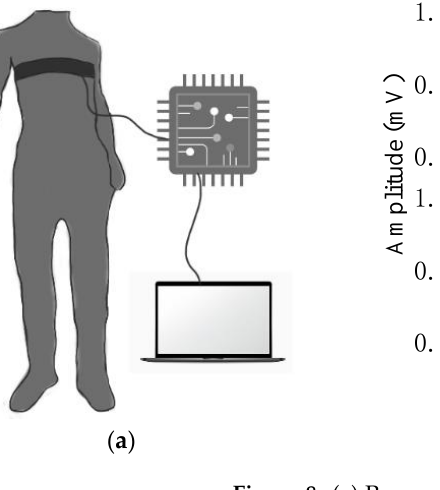
Figure 9. ( a ) Process of measuring ECG signal in rotating state. ( b ) ECG signal of woven fabric elec- trodes and standard medical electrodes in rotating state.